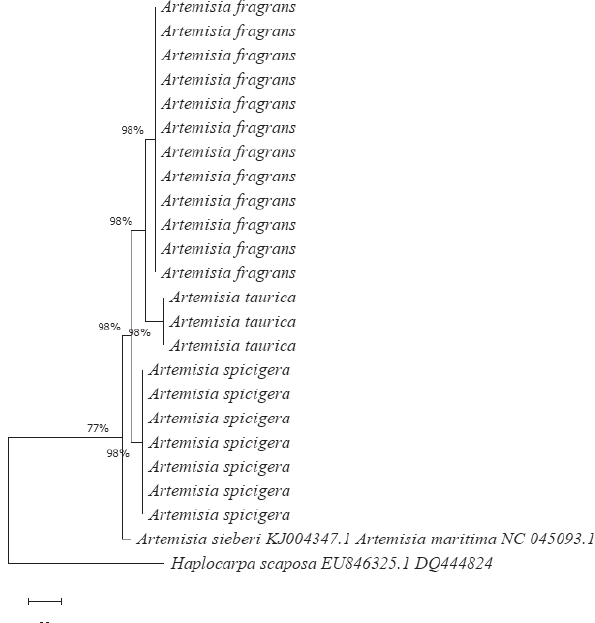
Figure 4. Maximum Parsimony tree obtained from the co-eval- uation of sequences of the ITS (ITS1-5.8S-ITS2) and trn T- trn L3’ regions of